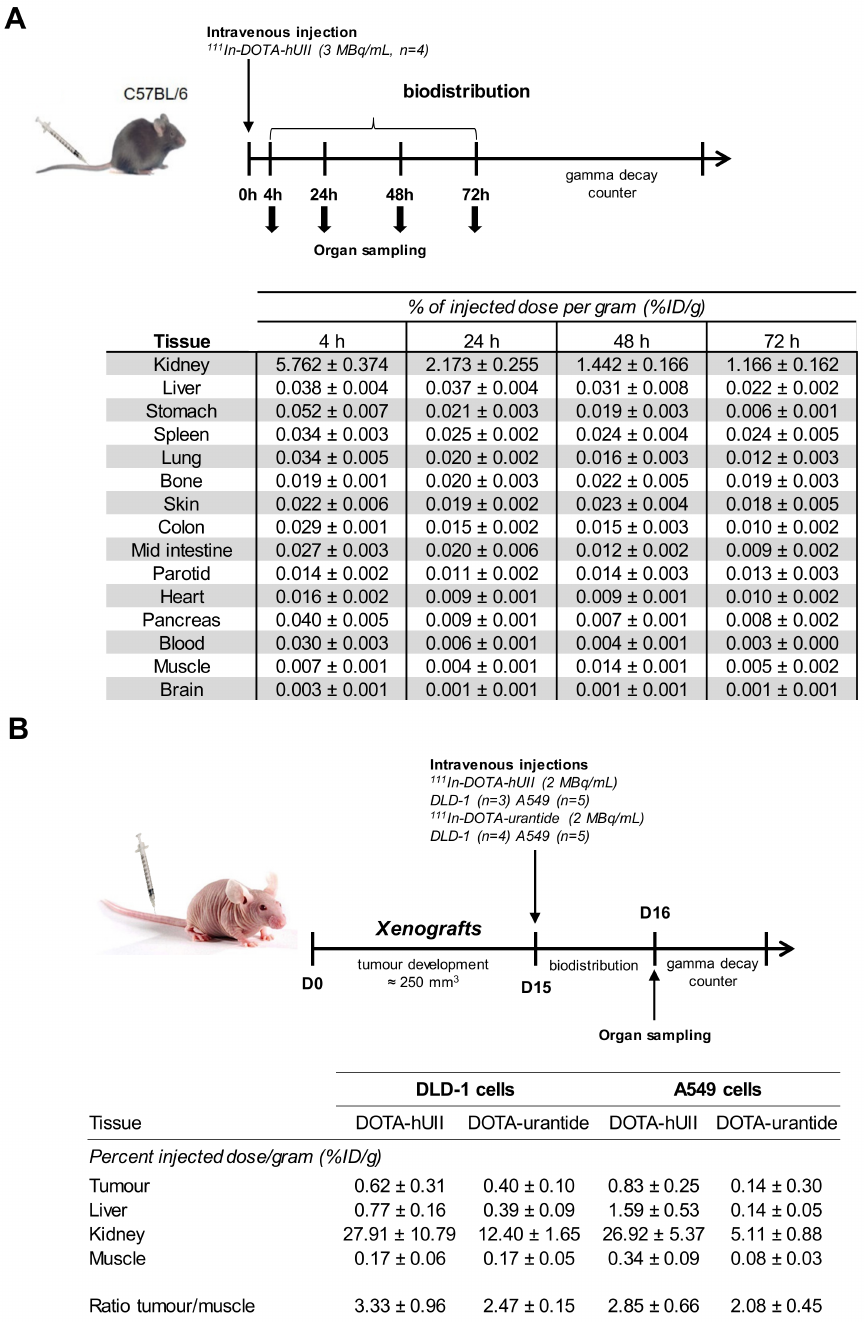
Figure 6. Biodistribution and tumour incorporation of 111 In-DOTA-hUII or 111 In-DOTA-urantide. ( A ) Biodistribution of 111 In-DOTA-hUII in C57BL / 6 mice. Data are expressed as percent injected dose per gram of tissue (%ID / g) at 4, 24, 48 and 72 h post-intravenous injection of 111 In-DOTA-hUII (3 MBq, 100 µ L). Data are mean ± SEM obtained from five animals. ( B ) Biodistribution and tumour-to-muscle uptake ratios in DLD-1 and A549 tumour-bearing nude mice treated with 111 In-DOTA-hUII or 111 In-DOTA-urantide. Data are expressed as percent injected dose per gram of tissue (%ID / g) at 24 h post-intravenous injection of 111 In-DOTA-hUII or 111 In-DOTA-urantide (2 MBq, 100 µ L, each). Data are mean ± SEM obtained from three to five